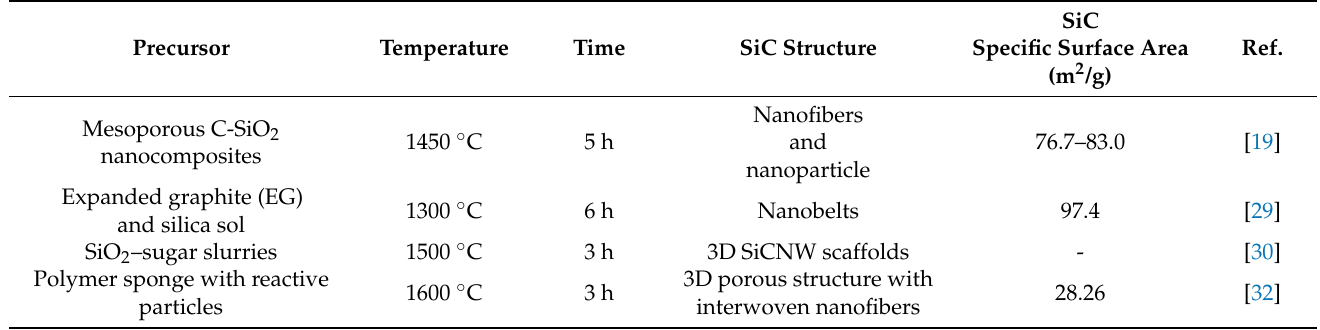
Table 1. Precursors, preparation conditions, structures, and specific surface areas of different nano- SiC